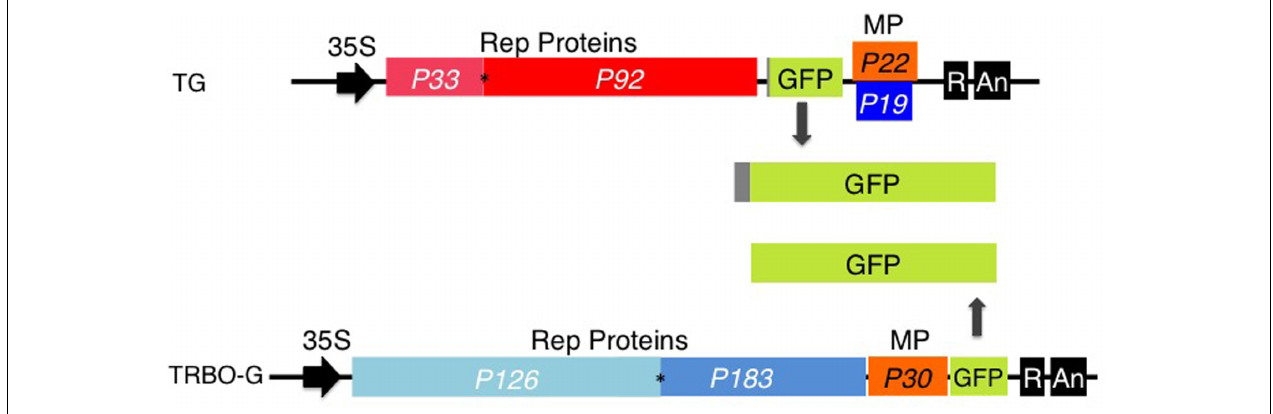
FIGURE 1 | TBSV-GFP (TG) and TRBO-GFP (TRBO-G) viral vectors. Only the relevant part of the insert in the binary vectors is illustrated. In vivo transcription of the viral (+) sense RNA genomes is driven by the upstream CaMV 35S (35S) promoter; the dark box labeled ‘R’ at the 3 (cid:48) end represents a ribozyme, ‘An’ refers to the poly (A) signal. The numerical “P” notations indicate the size in kDa of the proteins encoded by the viral genes. Rep Proteins indicate replication-associated proteins; MP, cell-to-cell movement protein; P19, suppressor of RNA silencing. GFP expressed from TG contains 17 extra amino acids that correspond to the remnant N-terminal end of the capsid protein. The asterisks indicate the presence of an amber read-through stop-codon. Further details on TG and TRBO-G were published previously (Lindbo, 2007; Shamekova et al.,